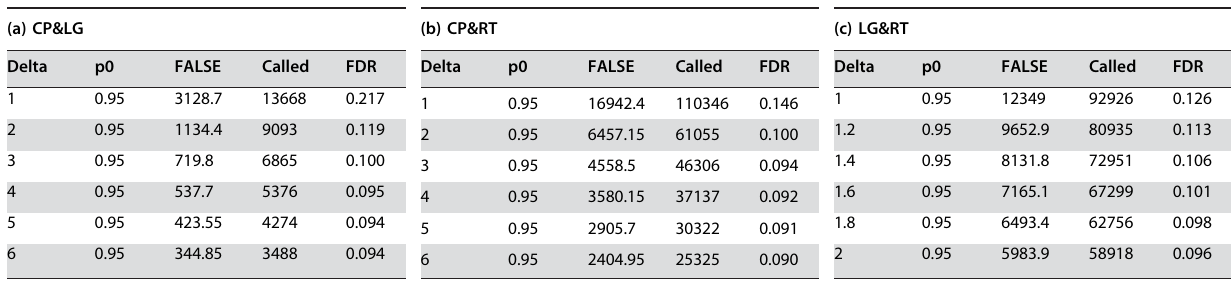
Table 1. Number of gene-chip predicted SFPs called at different threshold (delta) in datasets. .. ... .... ... ... .... ... ... .... ... ... .... ... ... .... ... ... .... ... ... .... ... ... .... ... ... .... ... ... .... ... ... .... ... ... .... ... ... .... ... ... .... ... ... .